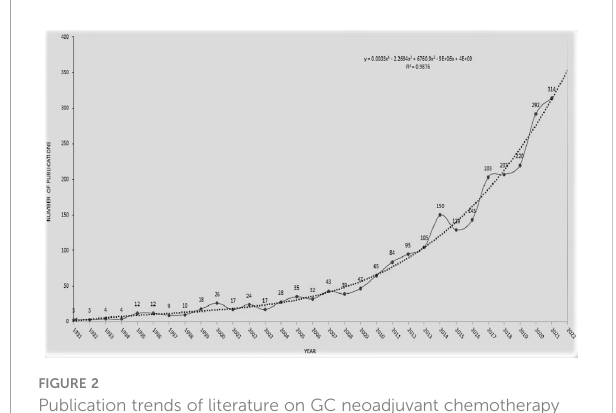
FIGURE 2 Publication trends of literature on GC neoadjuvant chemotherapy from 1991 to